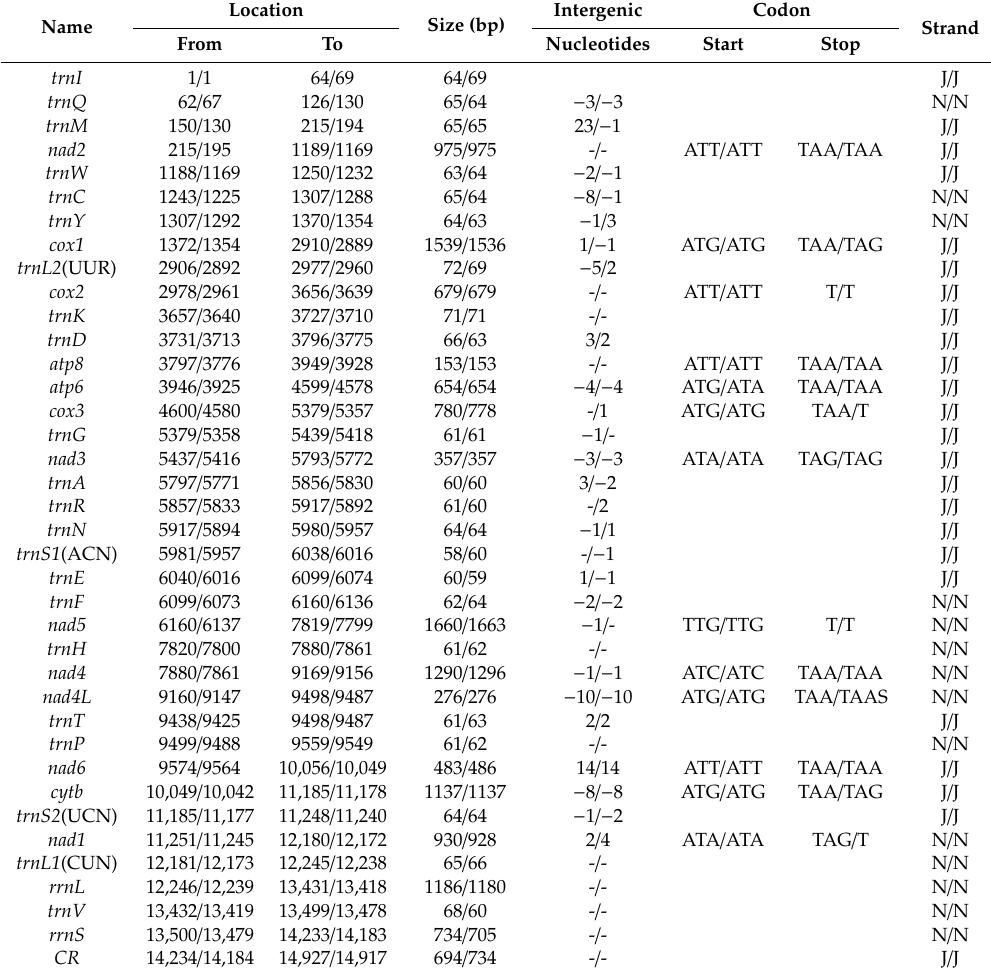
Table 2. Organization of the mtgenomes of P. chlorophana and T. sagittata.